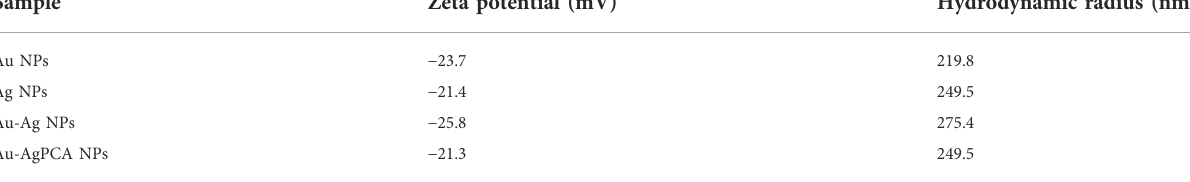
TABLE 2 Zeta potential and hydrodynamic radius of